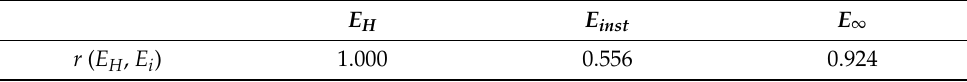
Table A1. Pearson’s correlation between the Young’s modulus measured by microindentation ( E H ) and relaxation ( E inst and E ∞ ); in both cases a positive correlation was found indicating that if there is a change in the elastic behavior, both the Young’s modulus E and the long-term stiffness E ∞ will be affected in the same proportion since their correlation level is >0.9. On the other hand, with the instantaneous modulus E inst a correlation ~0.5 was obtained, which indicates a similar trend but not precisely in the same proportion. This effect is noted in Table 1 of the main text, where both the values of Young’s modulus and long-term stiffness of the 1 and 4 kPa samples measured in detergent maintained a 4-fold identical proportion between the expected values measured with a different technique (AFM). r ( E H , E i ) = Pearson correlation with E H